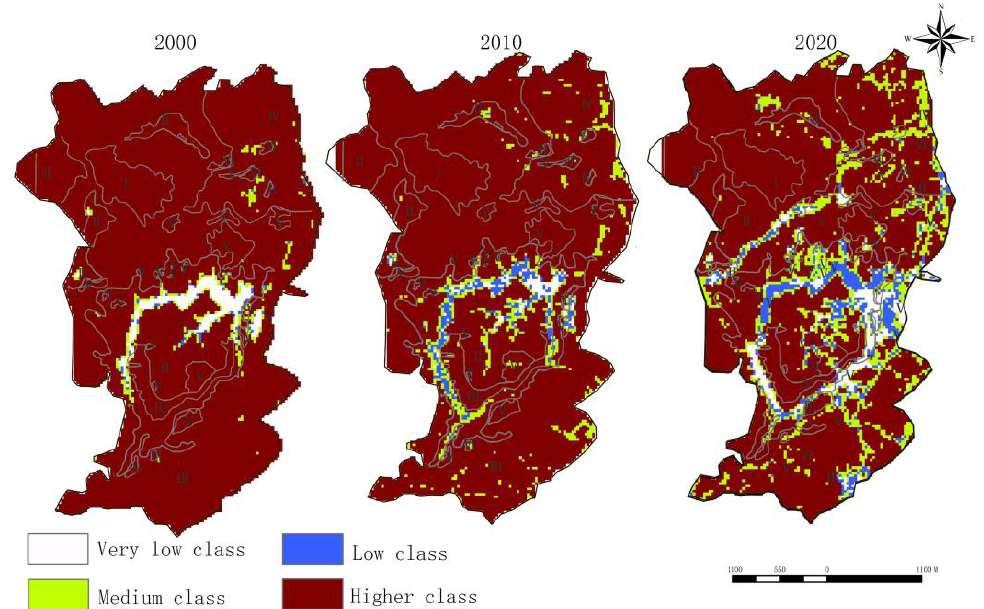
Figure 3. Spatial distribution of different grades of FVC in Nanhu Scenic Area from 2000 to 2020.